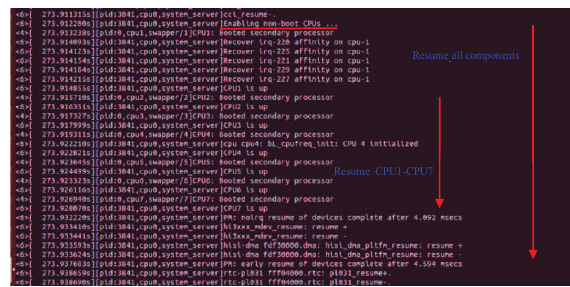
Figure 5. Switch operation flow of Resume mode